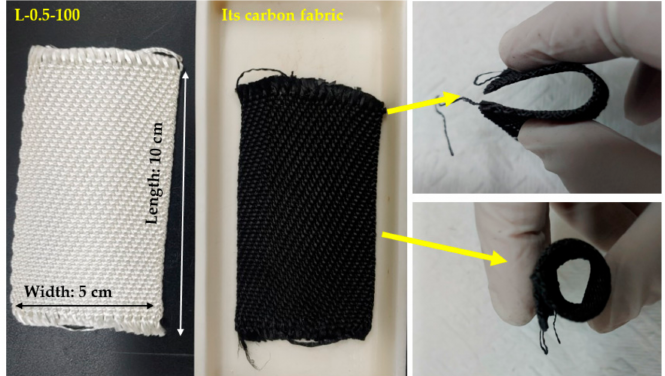
Figure 6. Photographs of lyocell fabric grafted with PAM via EBI and the corresponding carbon